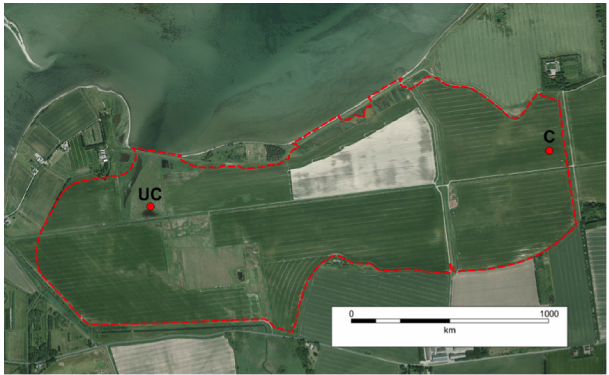
Figure 1. Map of Gyldensteen Strand with the location of the two sampling stations for collecting uncultivated (UC) and cultivated (C) soil cores. The dashed red line indicates the area flooded with seawater in March